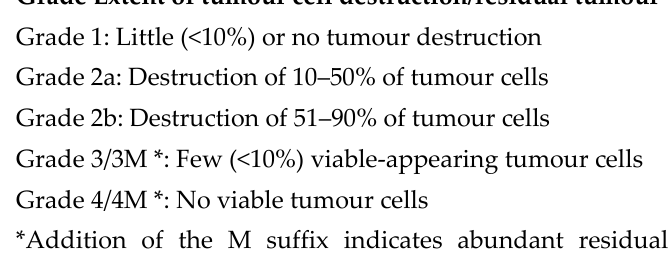
Figure 5. Regression grading scheme proposed by Evans et al . [149].